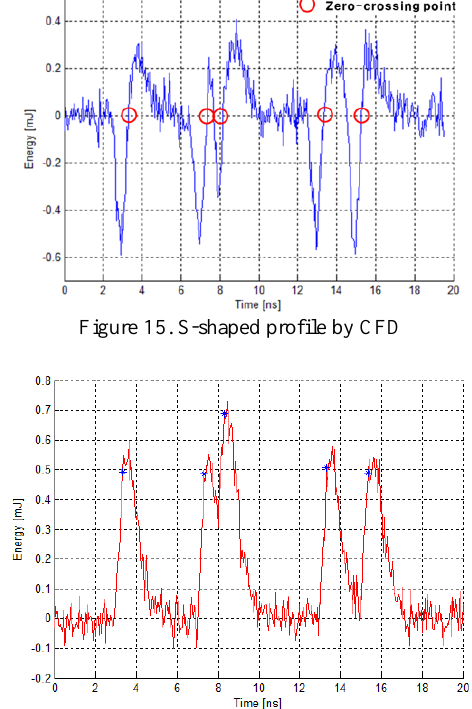
Figure 16. Waveform signal and detected return times (blue star: return times detected by